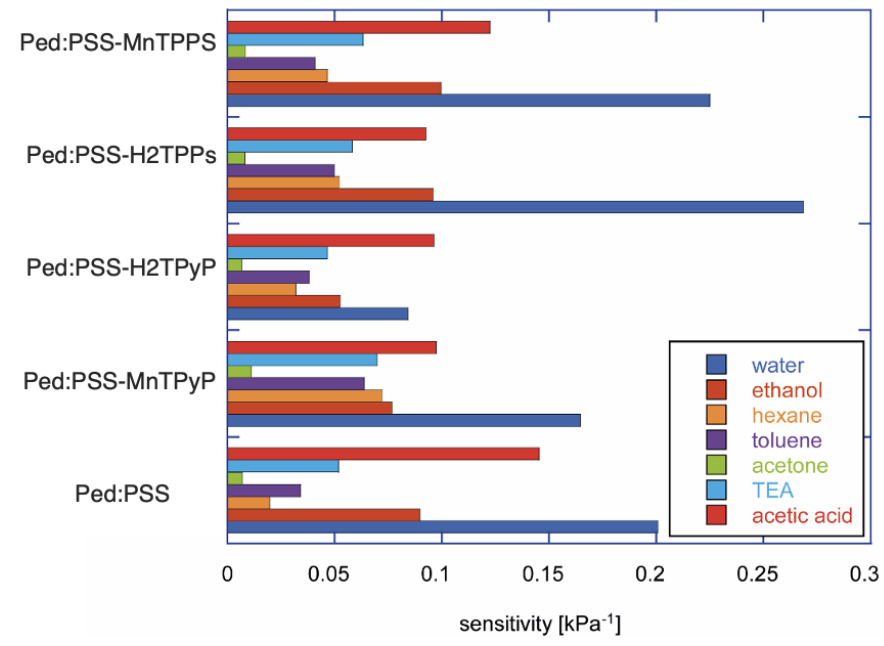
Figure 5. Sensitivity of sensors to the seven tested compounds.